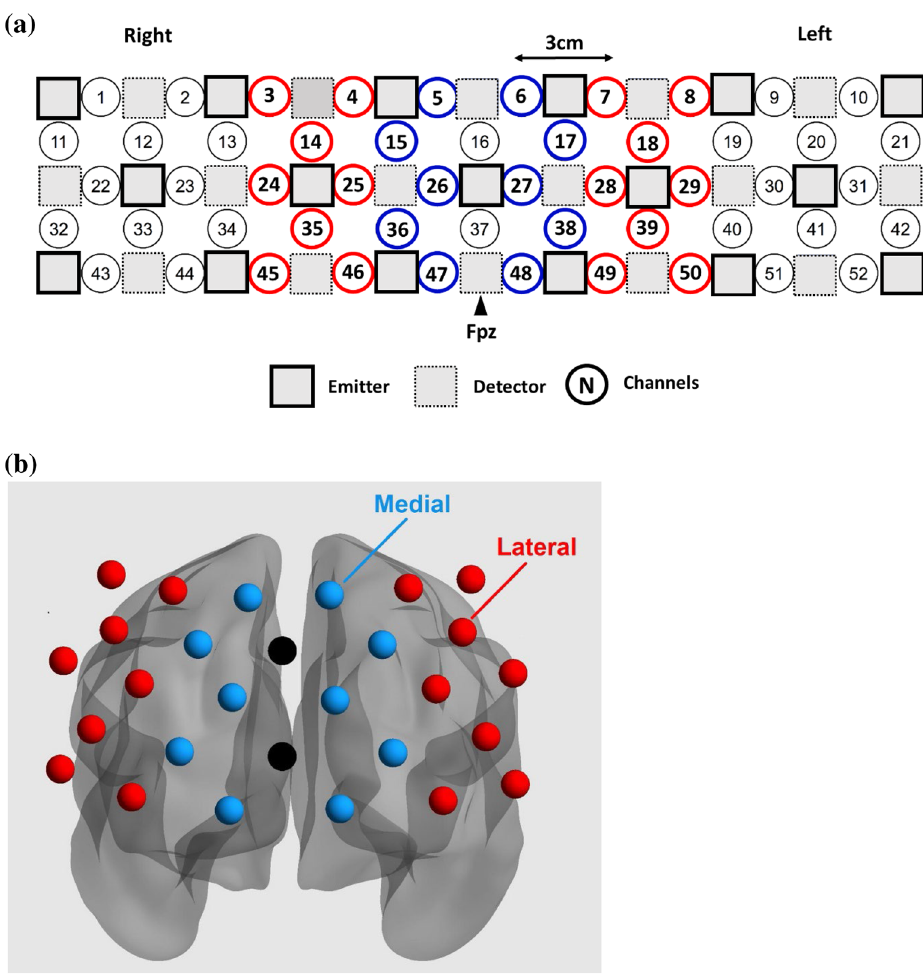
Figure 2. Arrangement of channels ( a ) in the sensor space and ( b ) in the brain space. Channels in red and blue represent the lateral and medial prefrontal cortex,